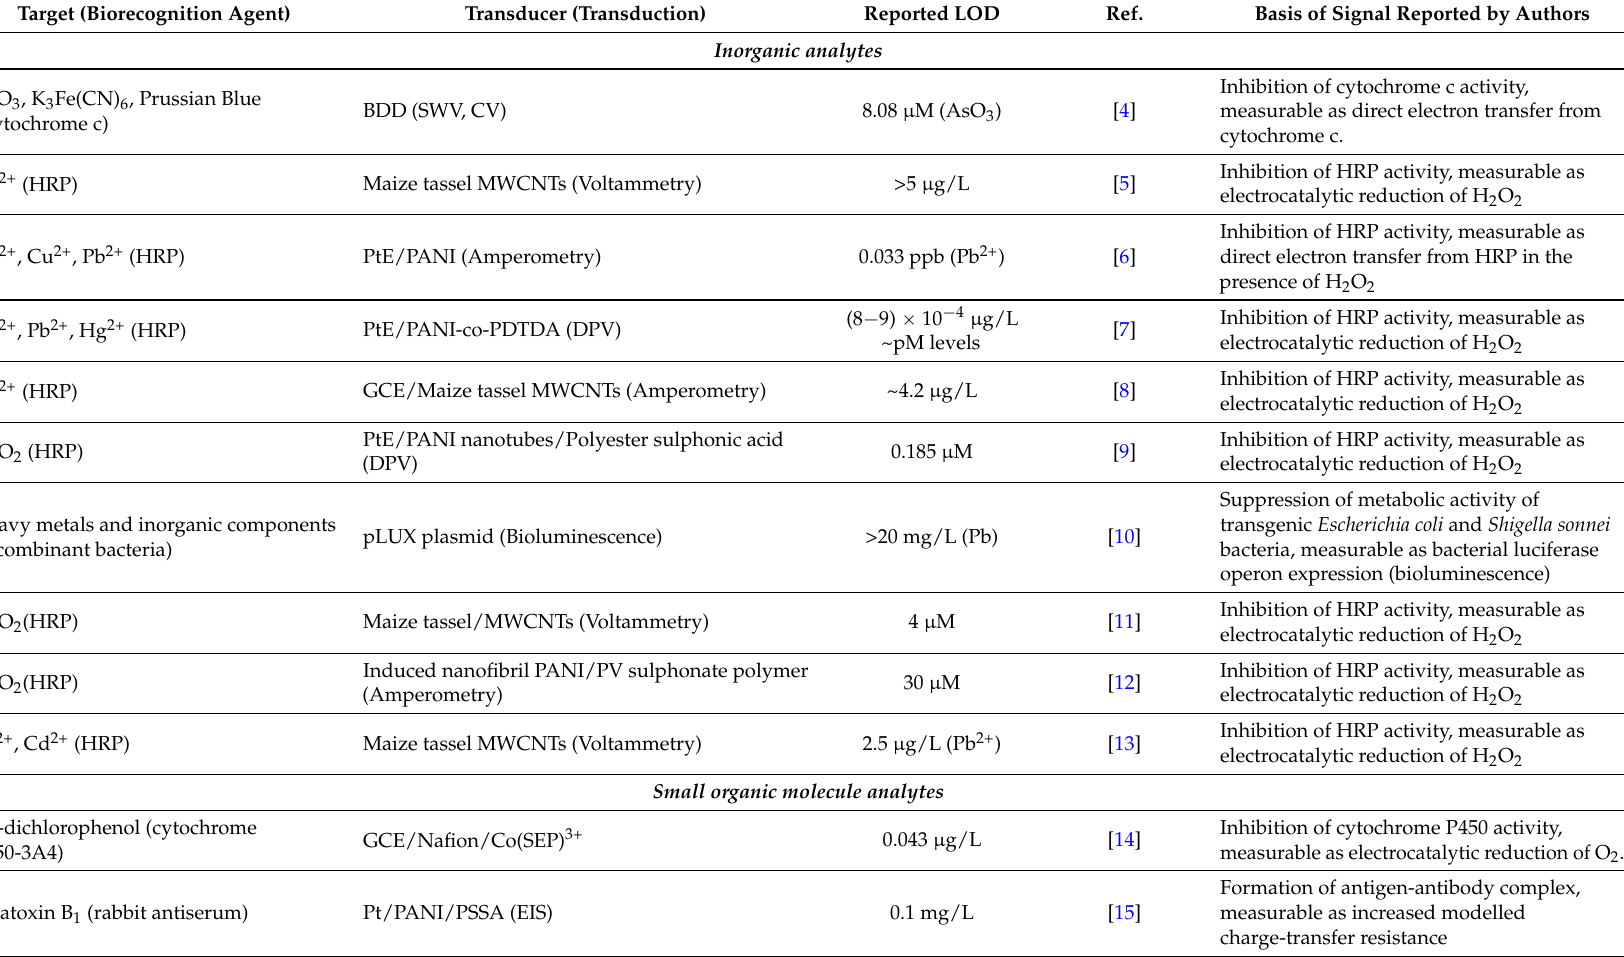
Table 2. Summary of available literature in biosensor-related fields in South Africa, categorised by analyte of interest (from